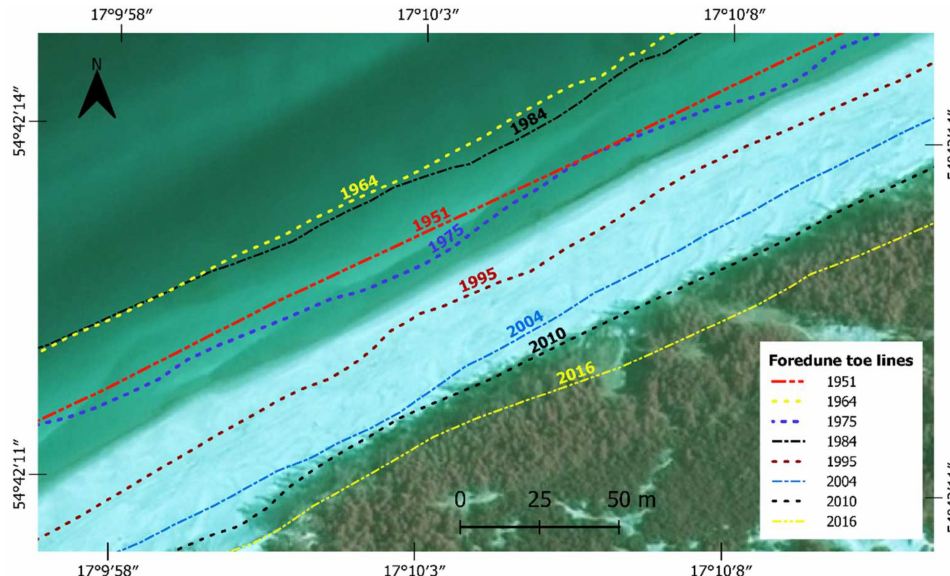
Figure 2. Foredune toe lines in following years on the orthophotomap from 2010. The position of the foredune toe line reflects the course of the shoreline in the given